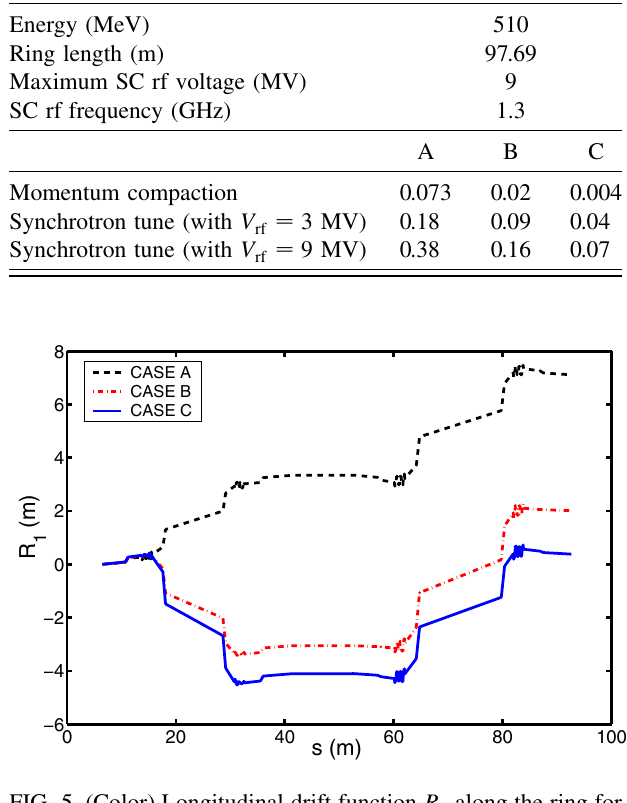
along the ring for 1